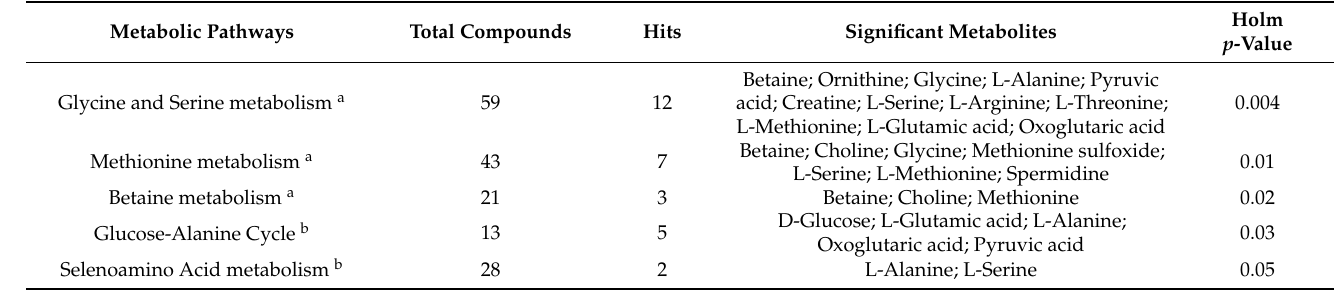
Table 6. Significant metabolic pathways identified from quantitative enrichment analysis and in- volved prior to occurrence of subclinical mastitis at − 8 and − 4 weeks before calving.